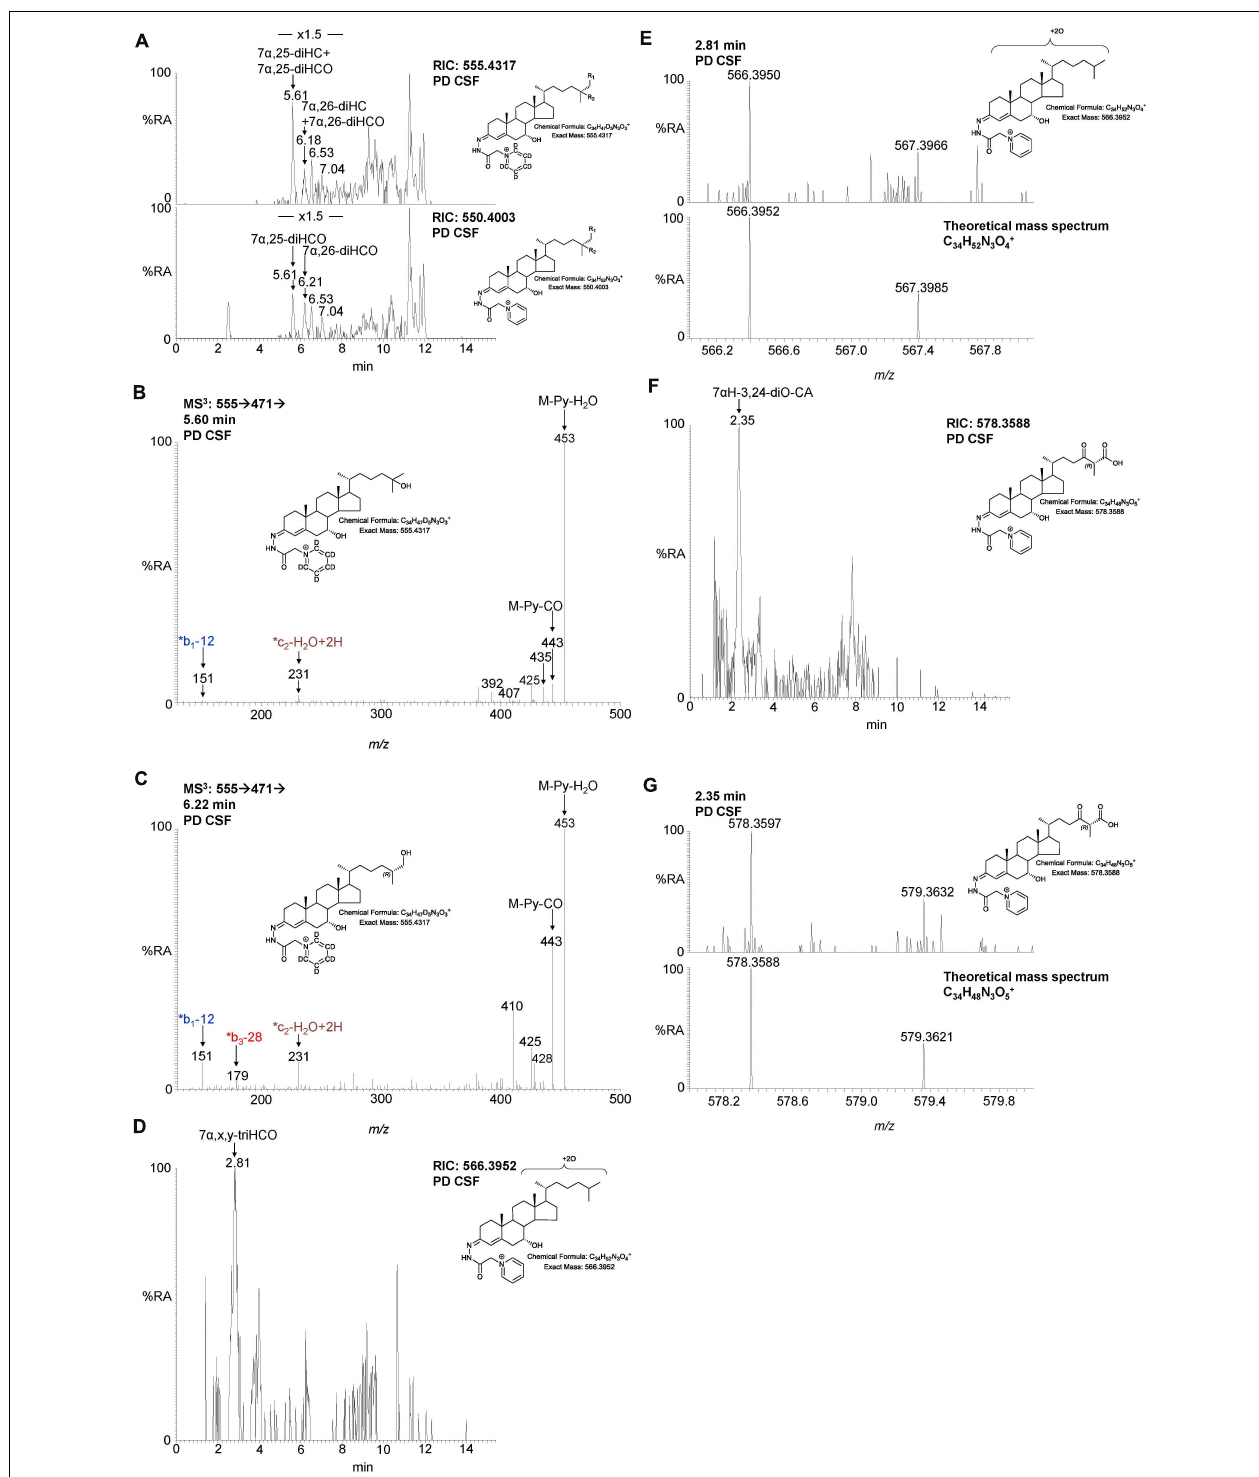
FIGURE 5 | LC-MS(MS n ) analysis of dihydroxycholesterols, dihydroxycholestenones, trihydroxycholestenones, and hydroxy bis oxocholestenoic acid in CSF. (A) RIC of 555.4317 ± 5 ppm (upper panel) and 550.4003 ± 5 ppm (lower panel) revealing 7 α ,25-diHC, 7 α ,26-diHC, 7 α ,25-diHCO, and 7 α ,26-diHCO. MS 3 (M + → M + -Py → ) spectra revealing (B) 7 α ,25-diHC and (C) 7 α ,26-diHC. (D) RIC of 566.3952 ± 3 ppm corresponding to 7 α ,x,y-triHCO. (E) High resolution (100,000) mass spectrum (upper panel) and theoretical mass spectrum (lower panel) of 7 α ,x,y-triHCO. (F) RIC of 578.3588 ± 3 ppm corresponding to 7 α H-3,24-diO-CA. (G) High resolution (100,000) mass spectrum (upper panel) and theoretical mass spectrum (lower panel) of 7 α H,3,24-diO-CA.